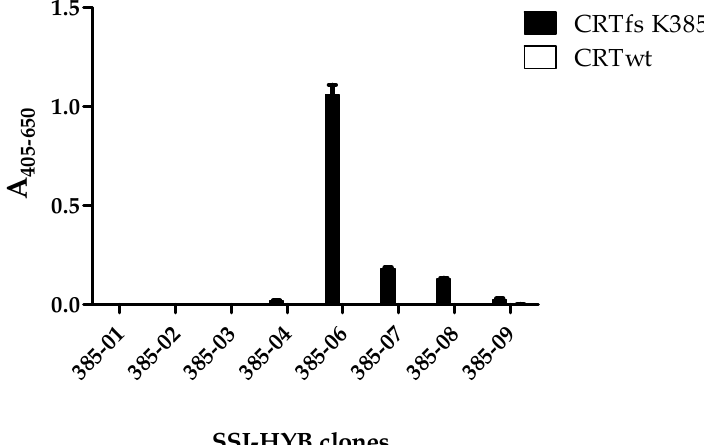
Figure 4. Reactivity of SSI-HYB clones to full-length frameshifted calreticulin (CRTfs) K385 and CRT wild-type (wt) analysed by enzyme-linked immunosorbent assay. Absorbances were corrected for background reactivity by subtracting reactivity from non-coated wells.